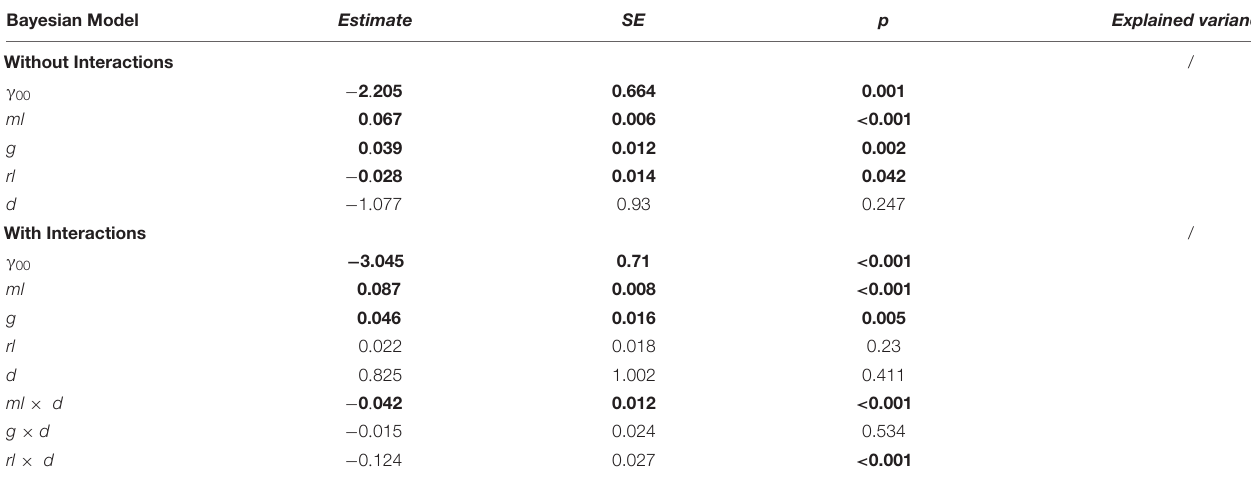
TABLE A1 | Predictiveness of different factors (i.e., ml , g , rl , and d ) regarding the criterion cogIll in two different Bayesian models (with and without interactions) including the Linda task. Bayesian